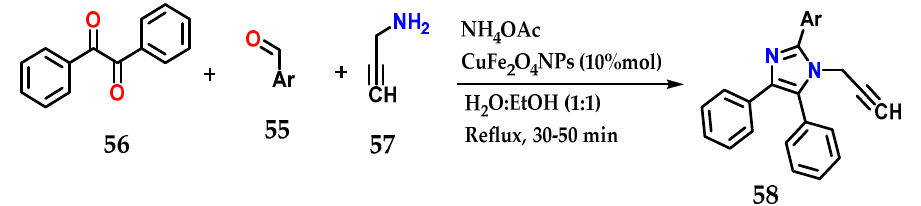
Figure 23. Tetrasubstituted imidazoles 58 were obtained by the coupling of benzyl 56 , functionalized aldehyde 55 , prop-2-ynylamine 57 and ammonium acetate using CuFe 2 O 4 NPs as the catalyst. In the presence of SO 42 − /Y 2 O 3 as a catalyst, the multicomponent condensation of benzyl 56 , aminoethylpiperazine 59 , various aldehydes 60 and ammonium acetate in ethanol at 80 ◦ C for 10 h was carried out to form tetrasubstituted 1,2,4,5-imidazole derivative 61 . The catalyst was reused up to five times with no significant loss in catalytic efficiency (Figure 24) [43].